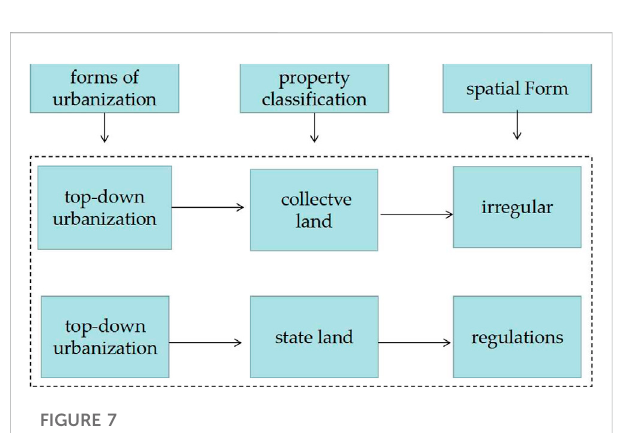
FIGURE 7 Two different types of urbanization coexist in China (Source: Drawn by the